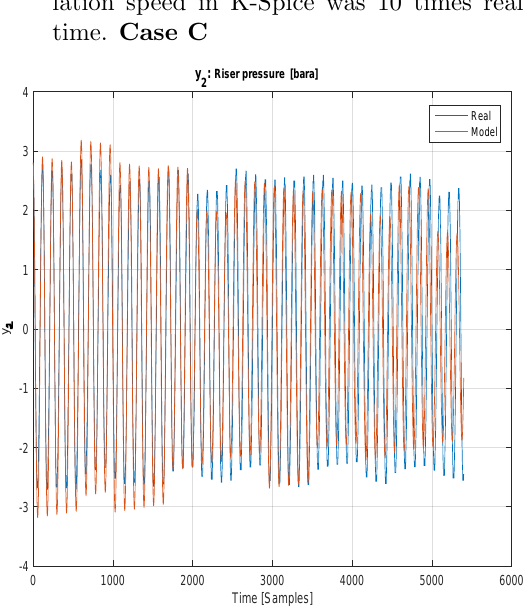
Figure 15: When stepping the topside choke, the input and output series were collected from the K-Spice model, with a length of N = 6000 samples. These inputs are from an experi- mental design, i.e. PRBS as in Eq. 6 where T min = 300 and T max = 700. These results are from a MATLAB script associated with the block diagram in Fig. 2. The simu- lation speed in K-Spice was 10 times real time. Case C